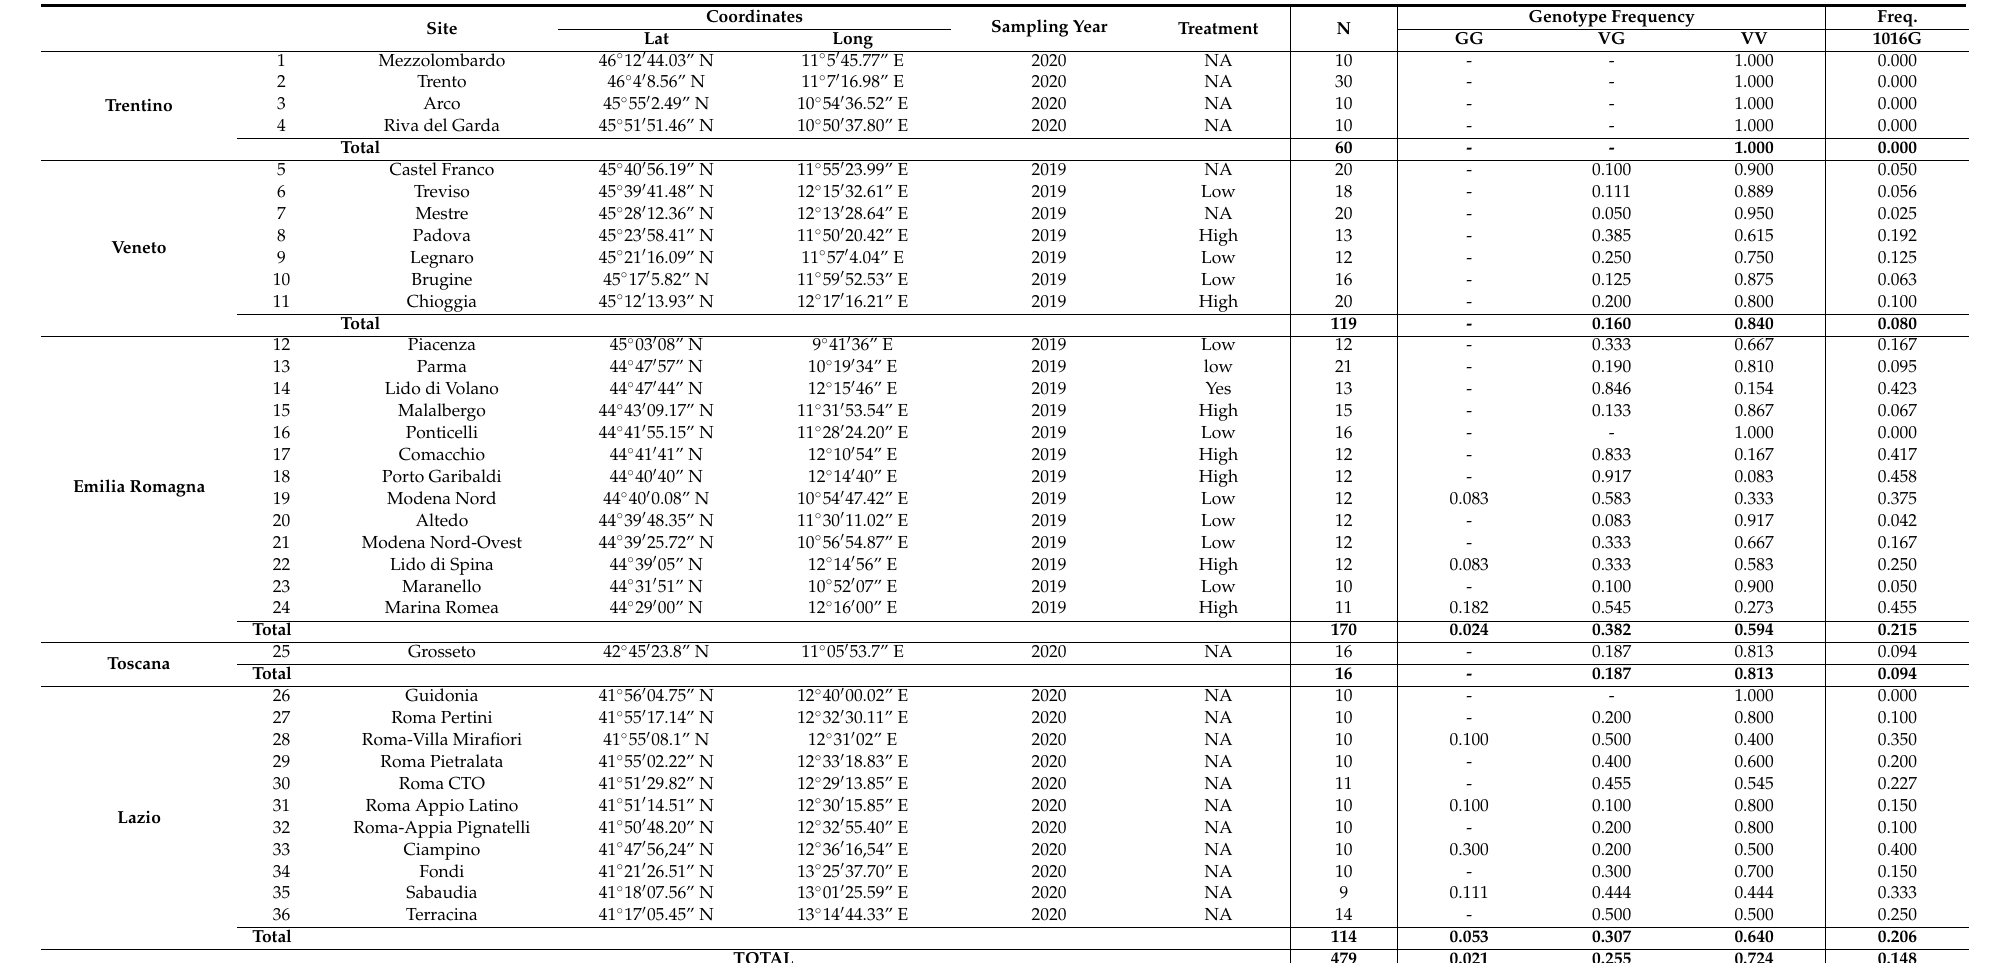
Table 1. Genotype and allele frequency for wildtype (1016V = V) and mutated (1016G = G) alleles in position 1016 of the vssc gene in Aedes albopictus field populations across Italy (listed from north to south). Pyrethroid treatments were defined as high when pyrethroid spraying was performed as a routine fortnightly or monthly throughout the whole mosquito season or as low when treatments where performed occasionally resulting in two treatments maximum throughout the mosquito